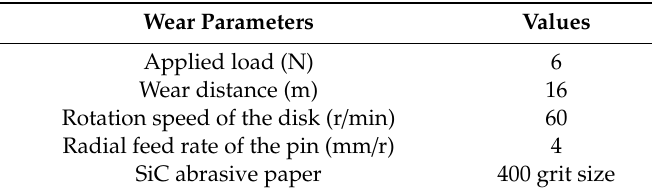
Figure 4. Schematic diagram of pin-on-disk wear testing: (1) weight, (2) clamp, (3) sample, (4) rotating direction of the disk, (5) abrasive paper, and (6) moving direction of the sample. Table 3. The wear parameters of the coatings.